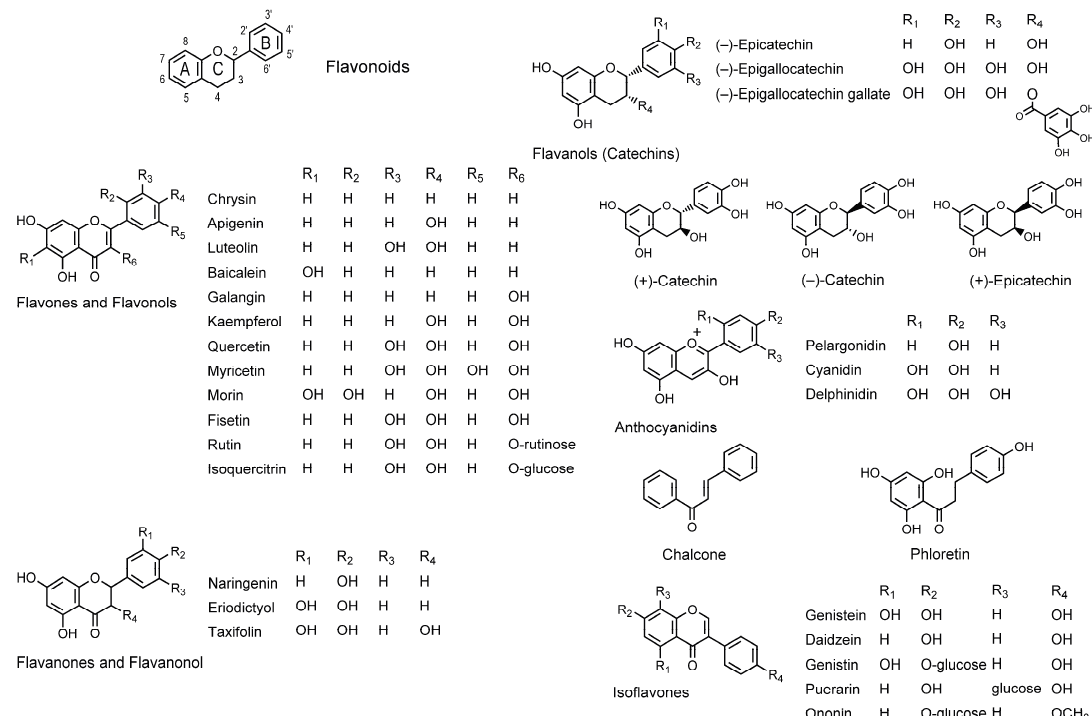
Figure 1. Structures of membrane-interactive